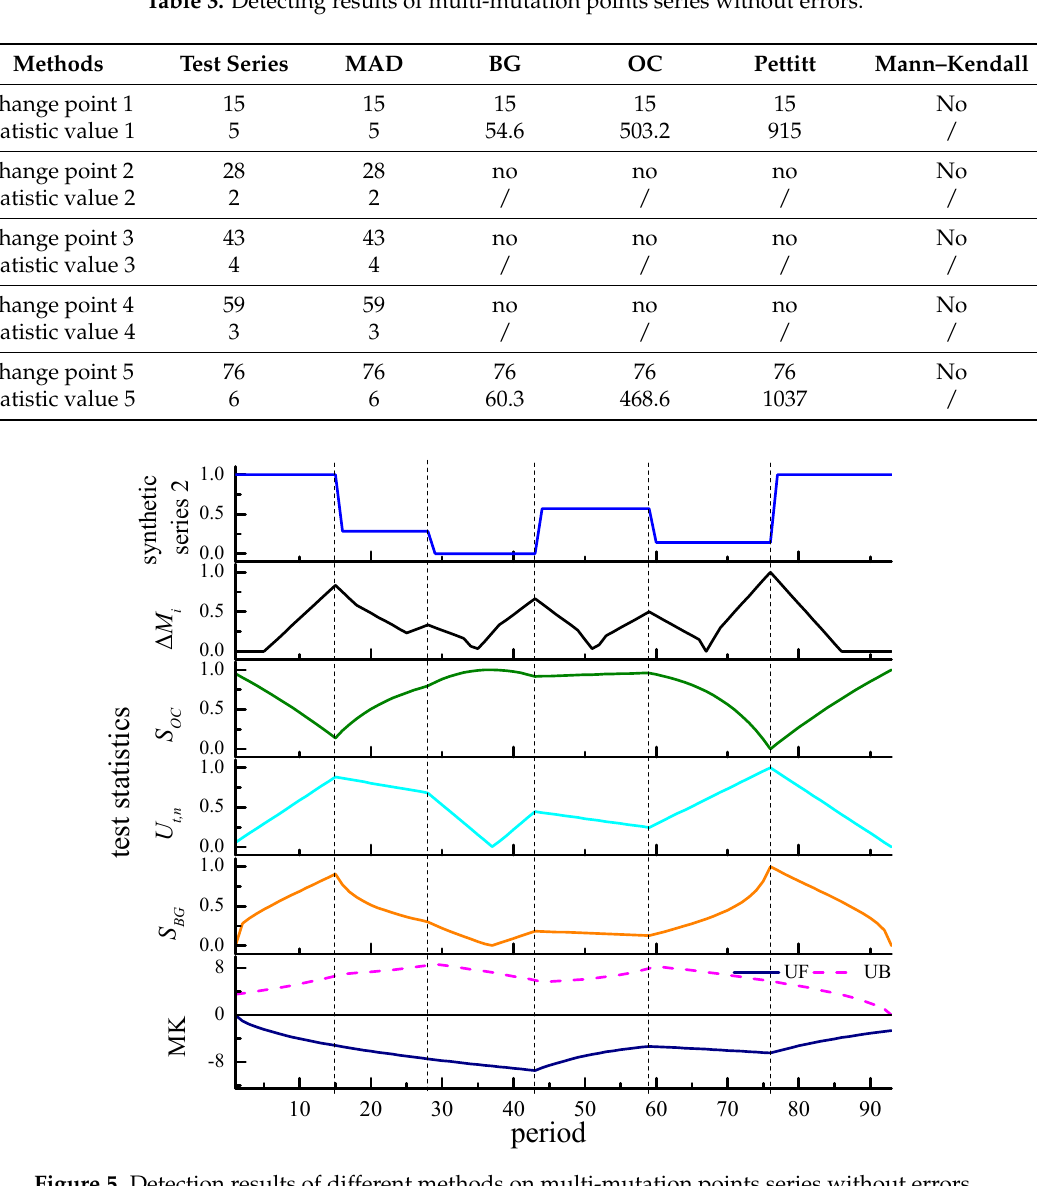
Figure 5. Detection results of different methods on multi-mutation points series without errors.